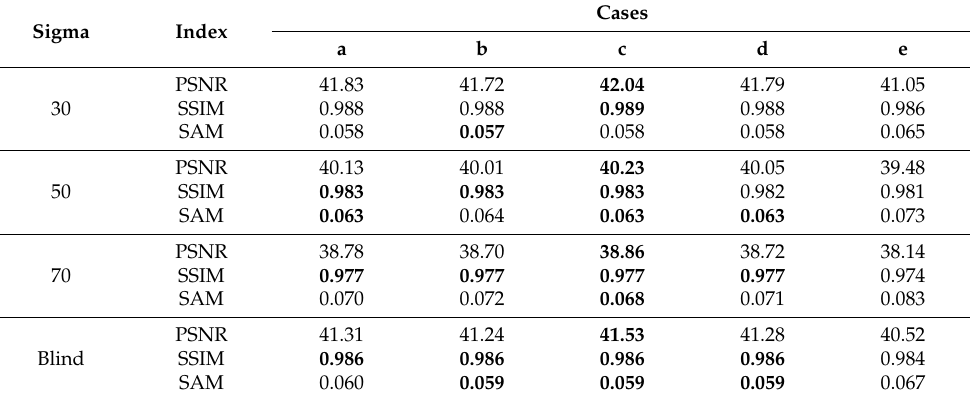
Table 9. Quantitative results on ICVL in Gaussian noise case under different network structures.